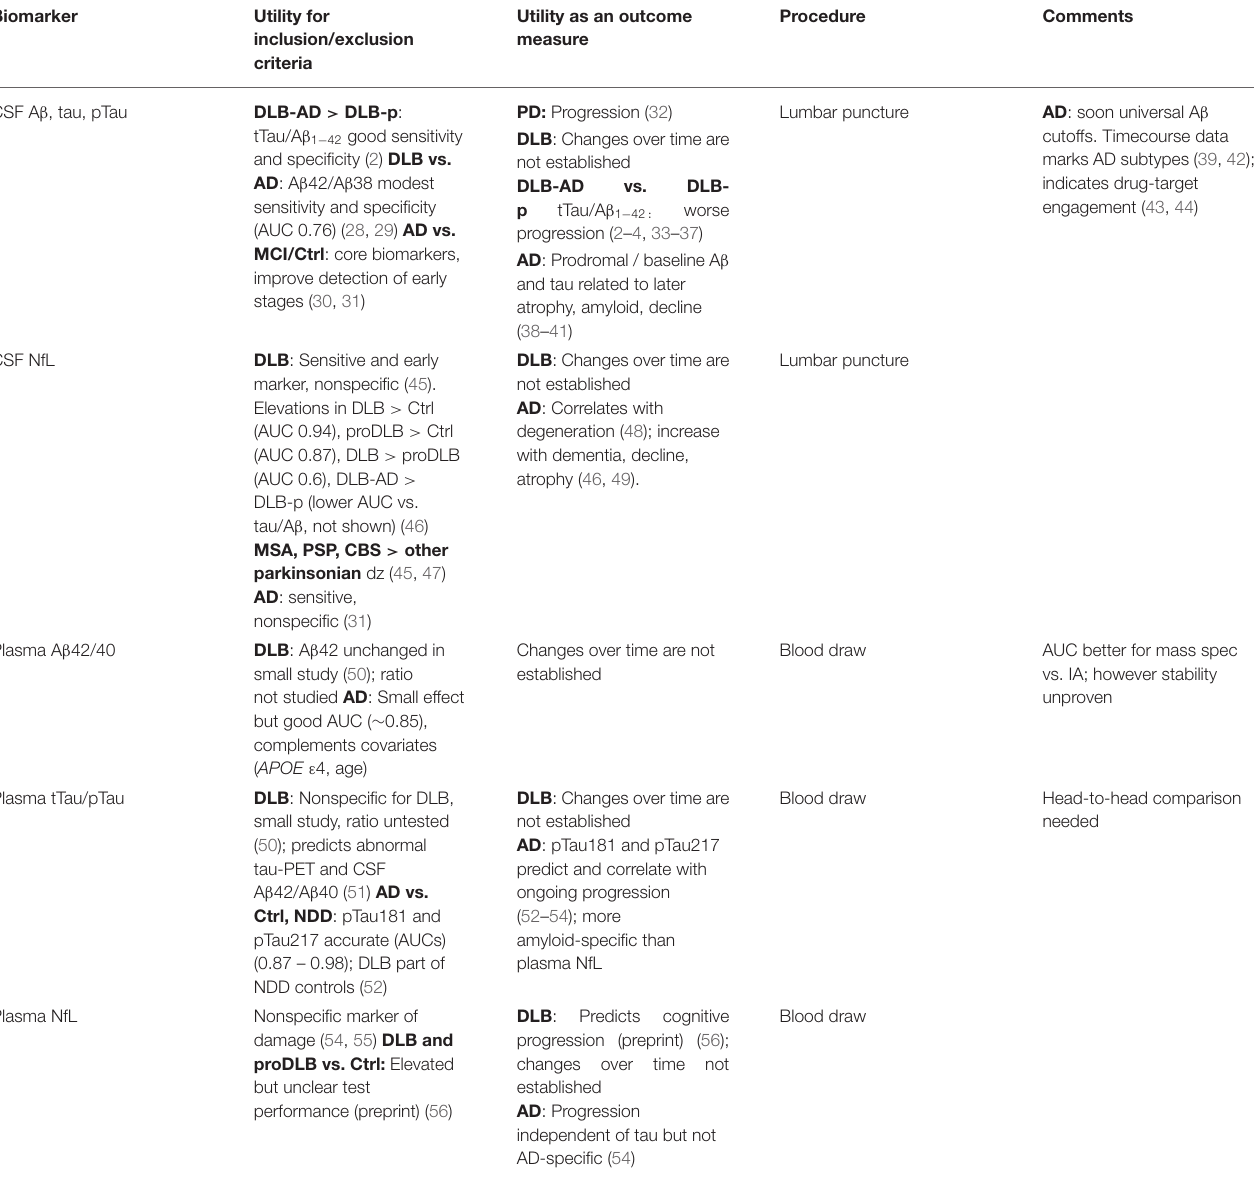
TABLE 2 | Fluid and tissue biomarkers of AD pathology.